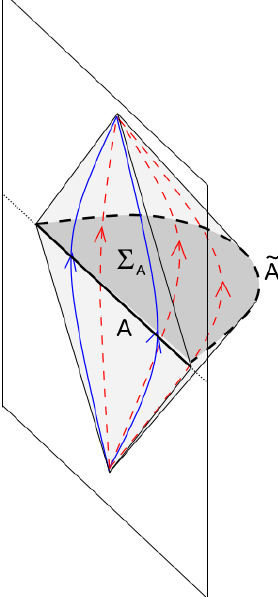
JHEP08(2017)057